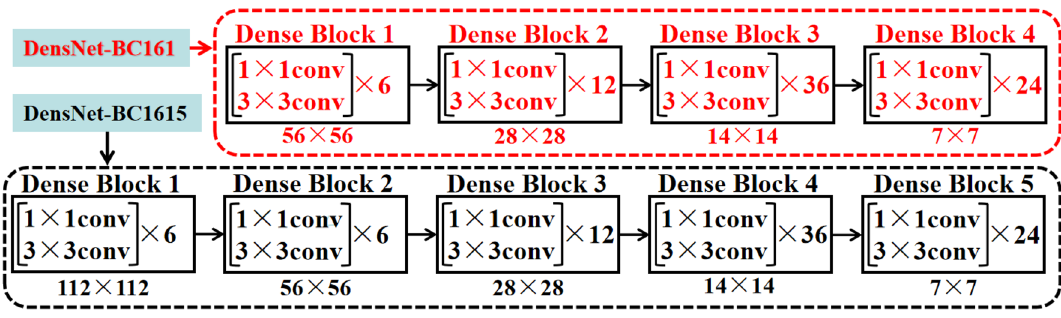
Figure 3. A schematic of model structure adjustment for